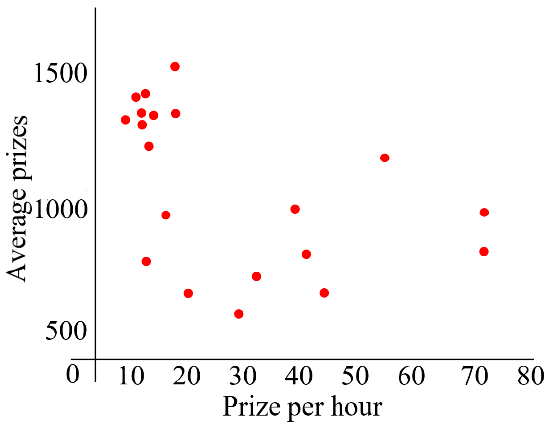
Figure 5. Top 20 average prizes and development times.